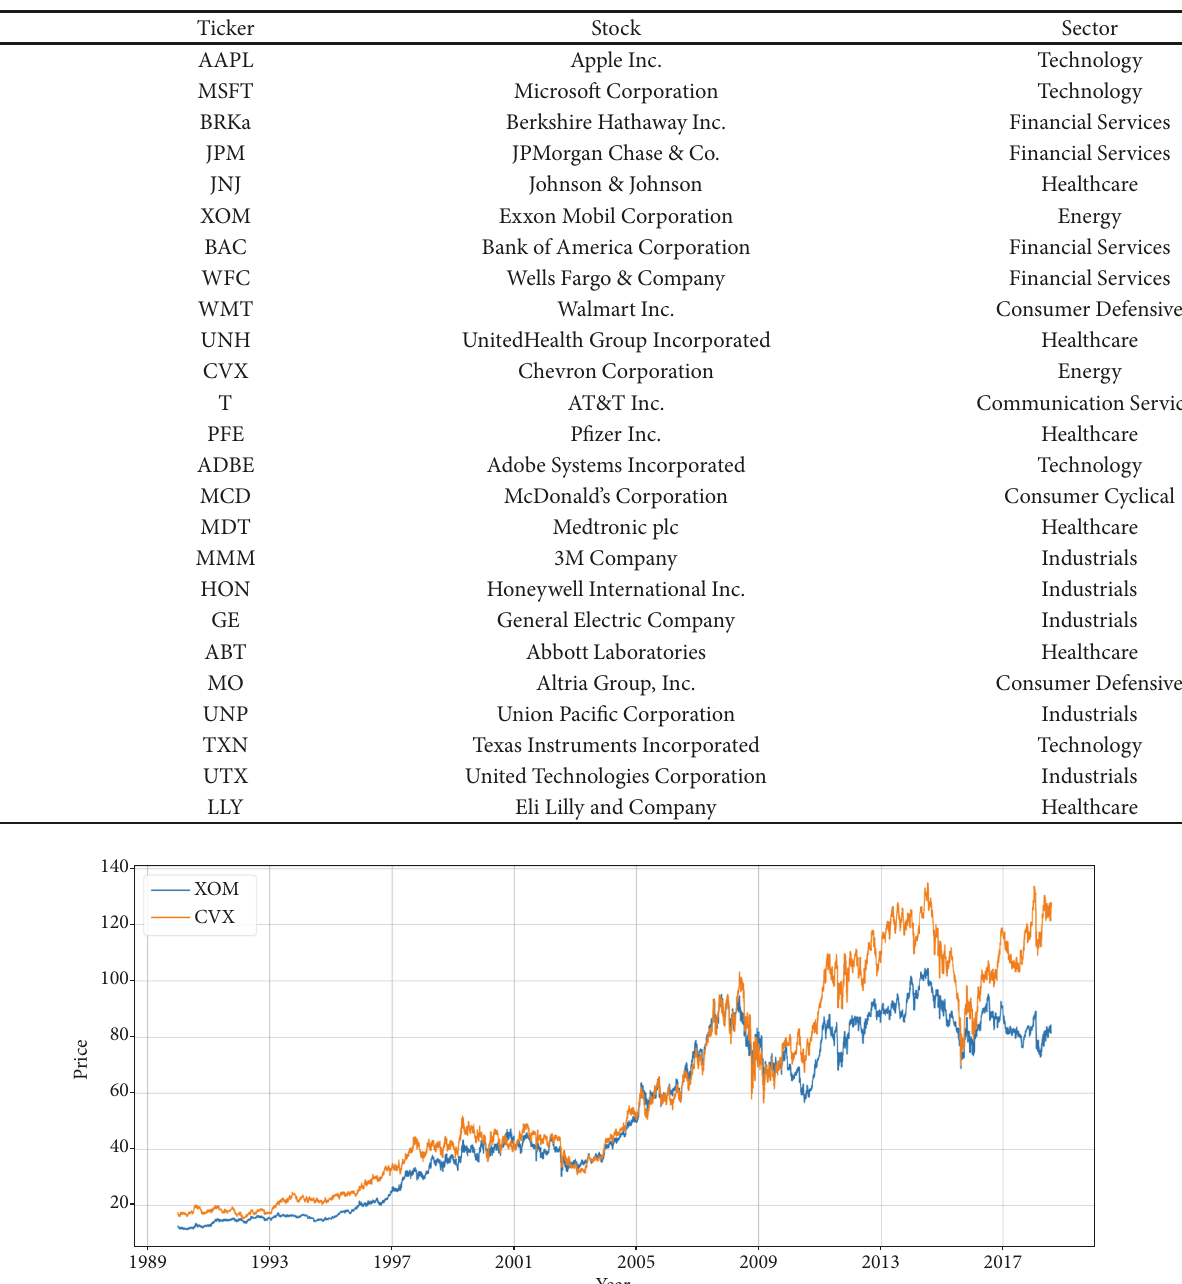
Table 1: The 25 stocks on the S&P 500 Index used in this study.